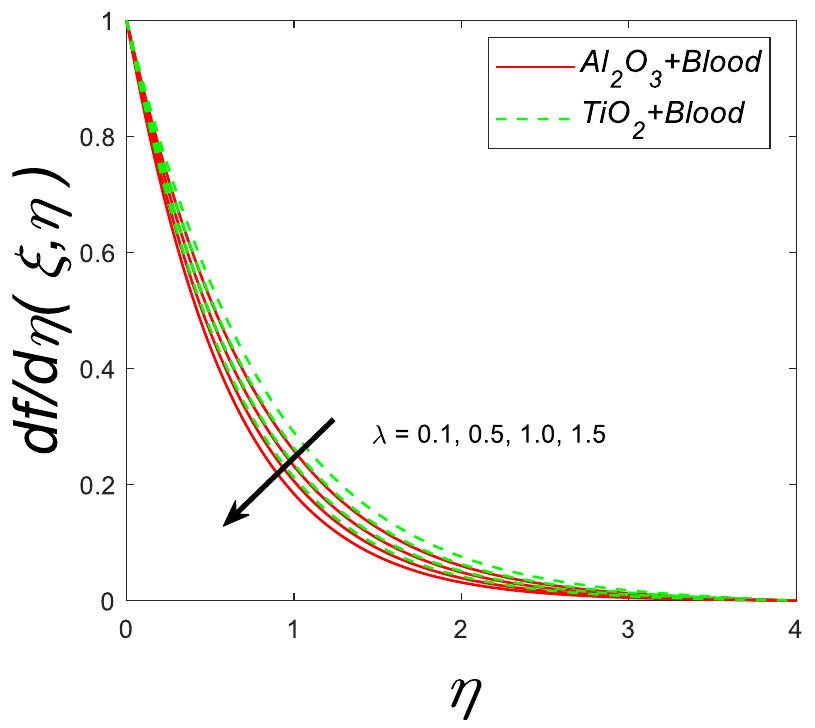
𝜋 , 𝜉 = 0.1,𝑅𝑑 = , ξ = 0.1, Rd = 0.1, 3 3